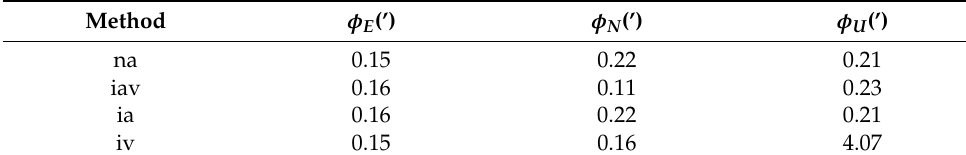
φ Table 1. RMSE values of in the cases of the initial misalignment angles φ Figure 5. The error curves of in the cases of the initial misalignment angles U Table 1. RMSE values of φ in the cases of the initial misalignment angles [ 0.2 ◦ 0.2 ◦ 2 ◦ ] T .